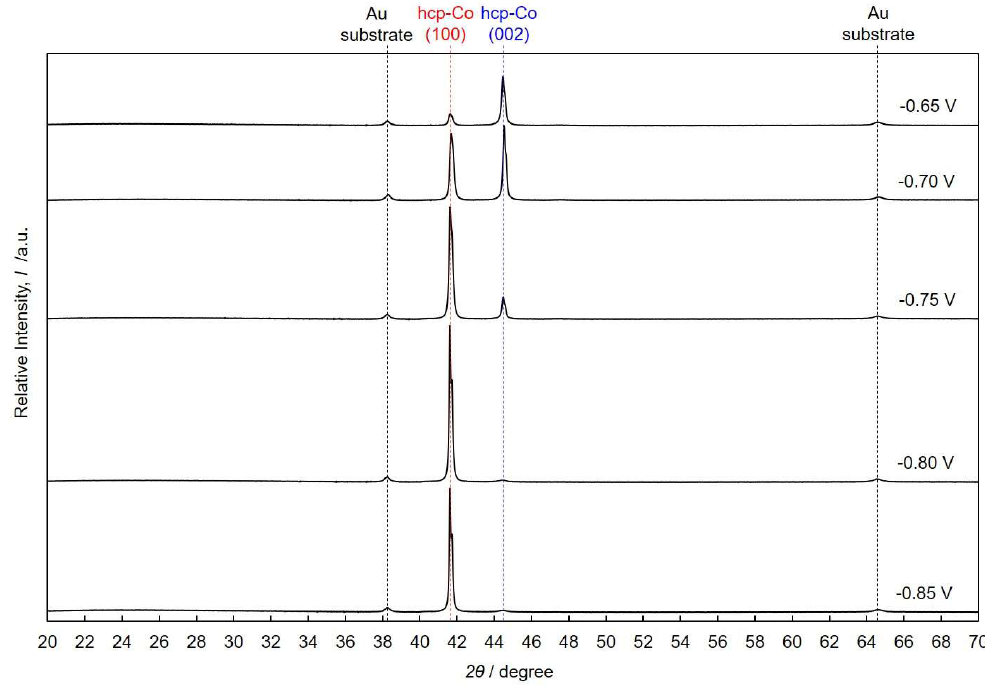
Figure 7. X-ray diffraction patterns of Co nanocrystal arrays that were electrodeposited at cathode potential of −0.85 V, −0.80 V, −0.75 V, −0.70 V and −0.65 V.